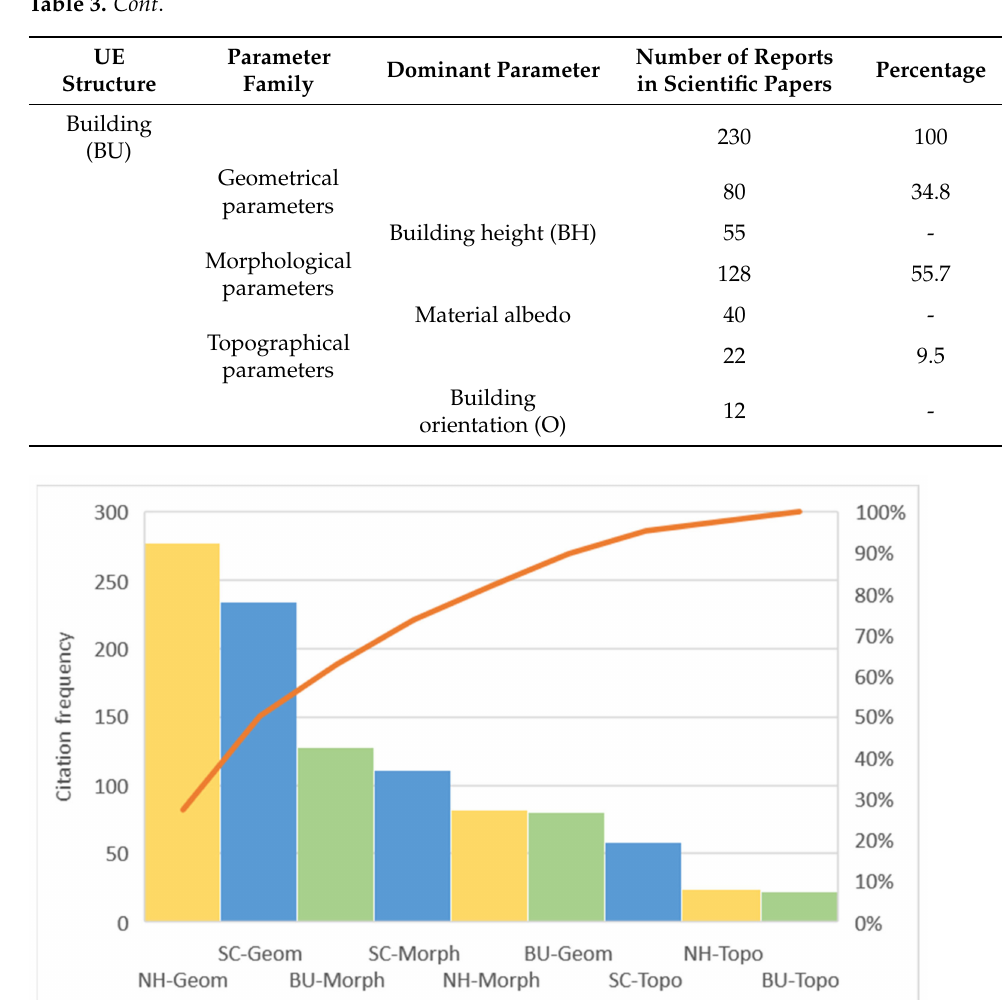
Figure 3. Pareto diagram. The frequency of scientific paper citations based on the analysis of the parameters’